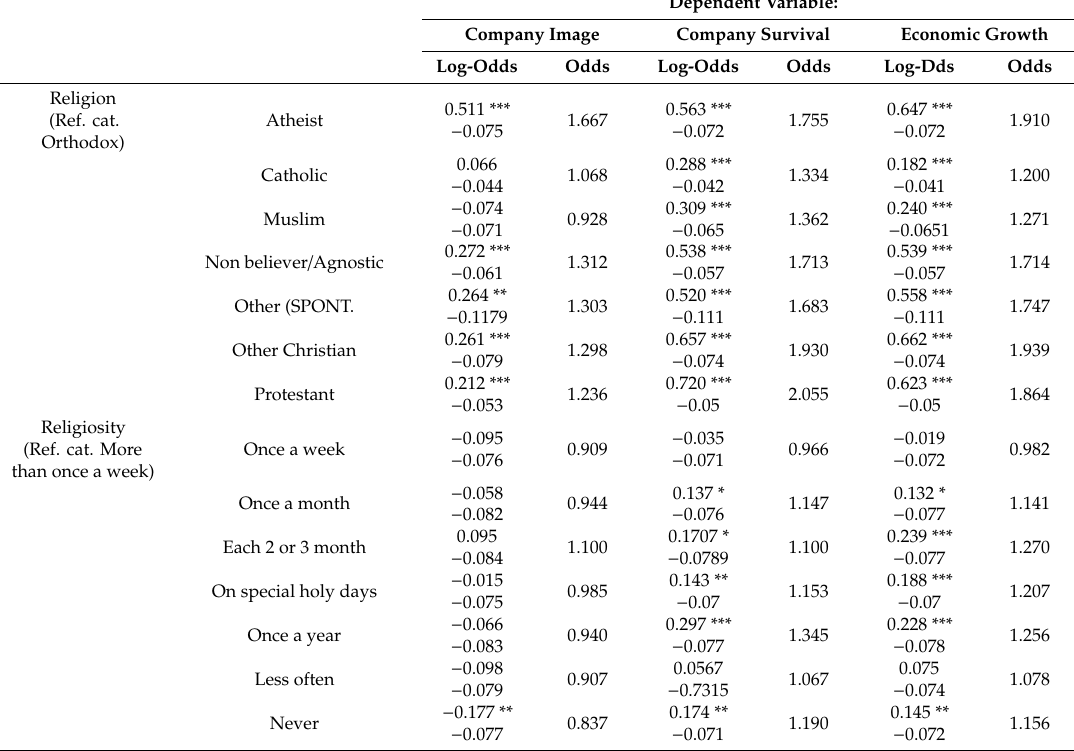
Table 4. Logistic regression results and innovation